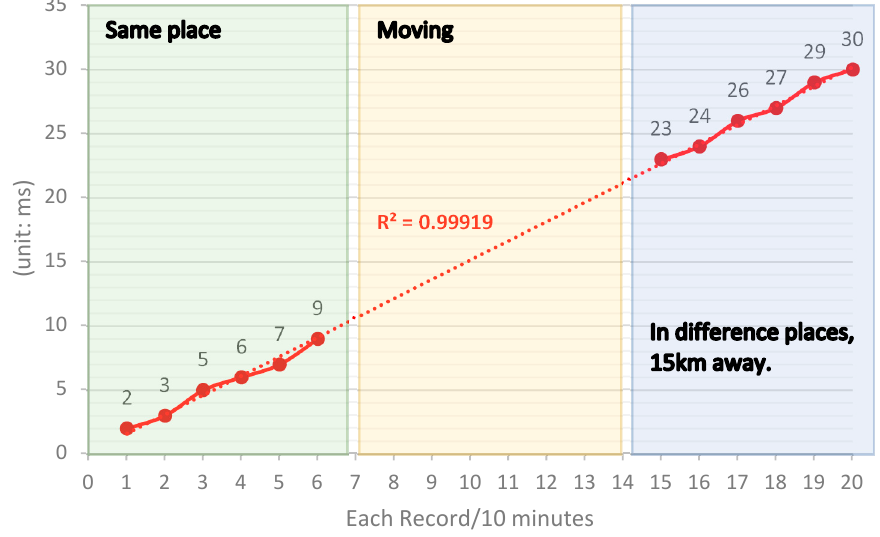
Figure 22. The time synchronization experiment with a distance of 15 km.